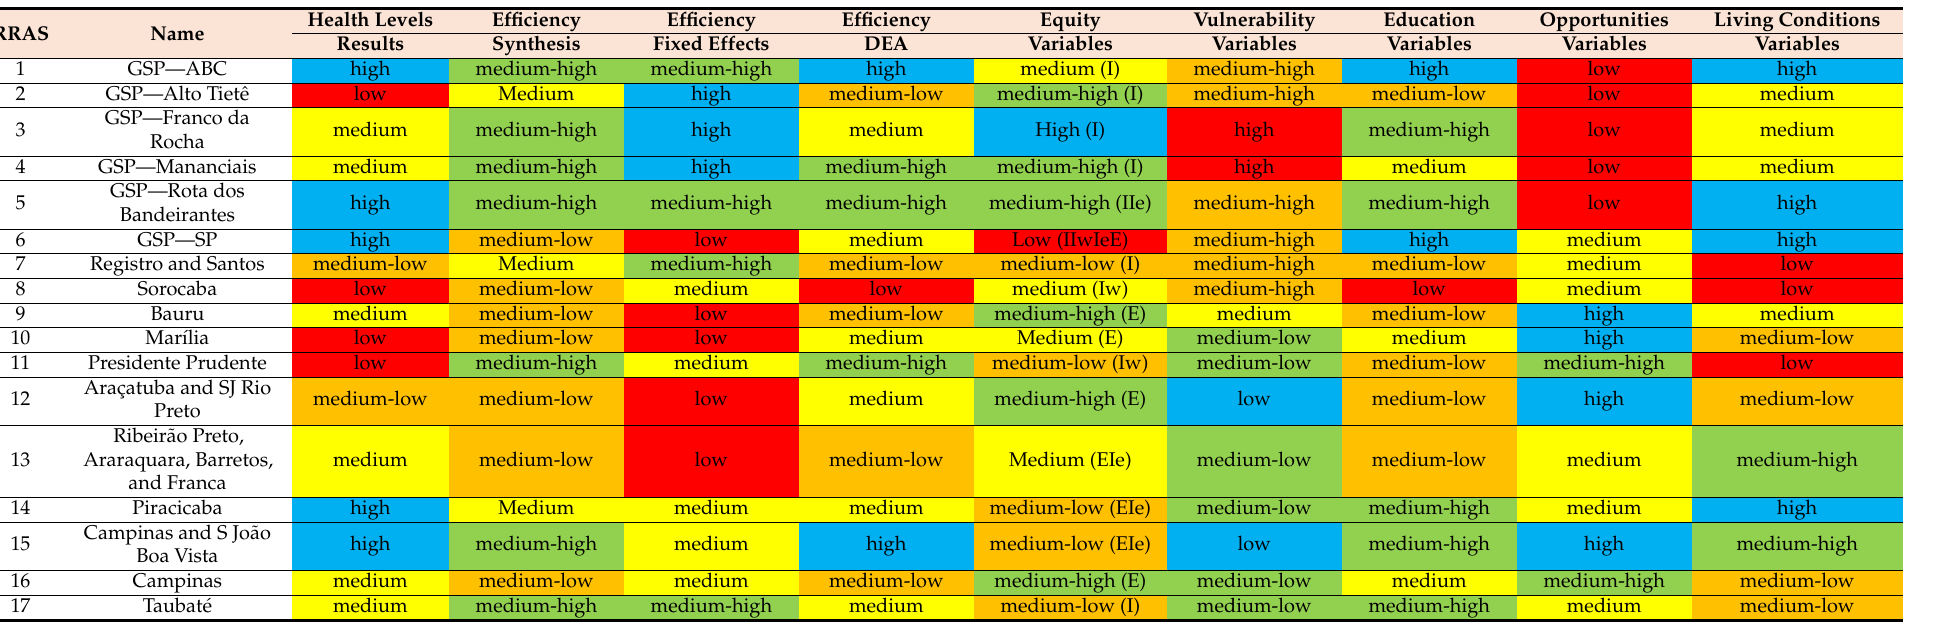
Table 3. Synthesis of health levels results, efficiency and contextual variables, according to the RRAS. Municipalities of the State of SP, 2000 and